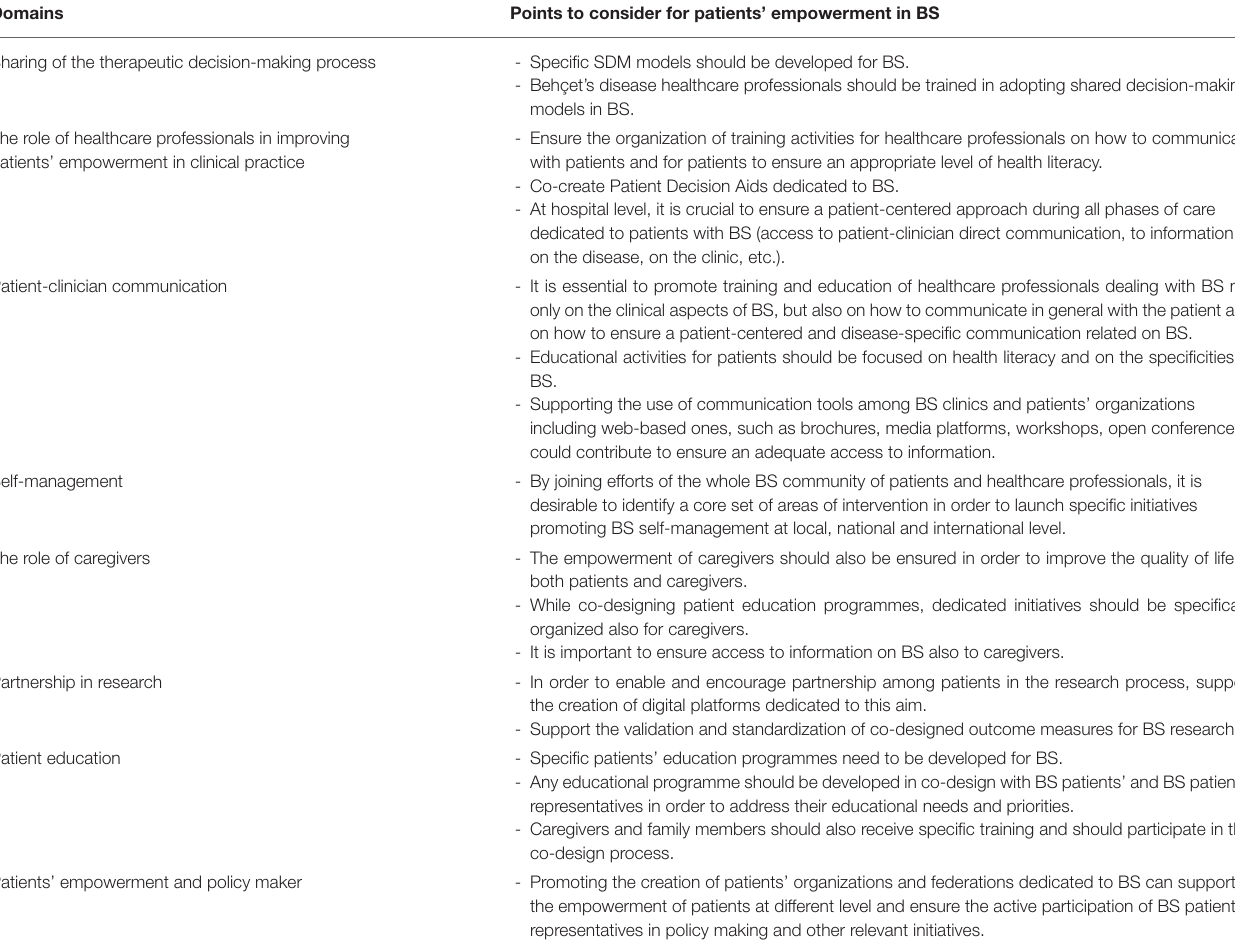
TABLE 1 | Points to consider to promote patients’ empowerment in BS. Domains Points to consider for patients’ empowerment in BS Sharing of the therapeutic decision-making